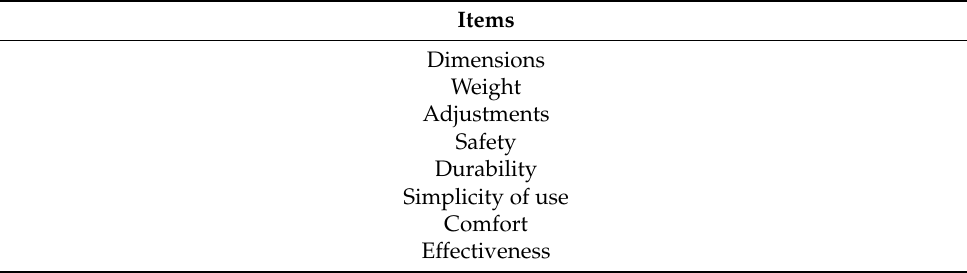
Table 3. Satisfaction evaluation item table.